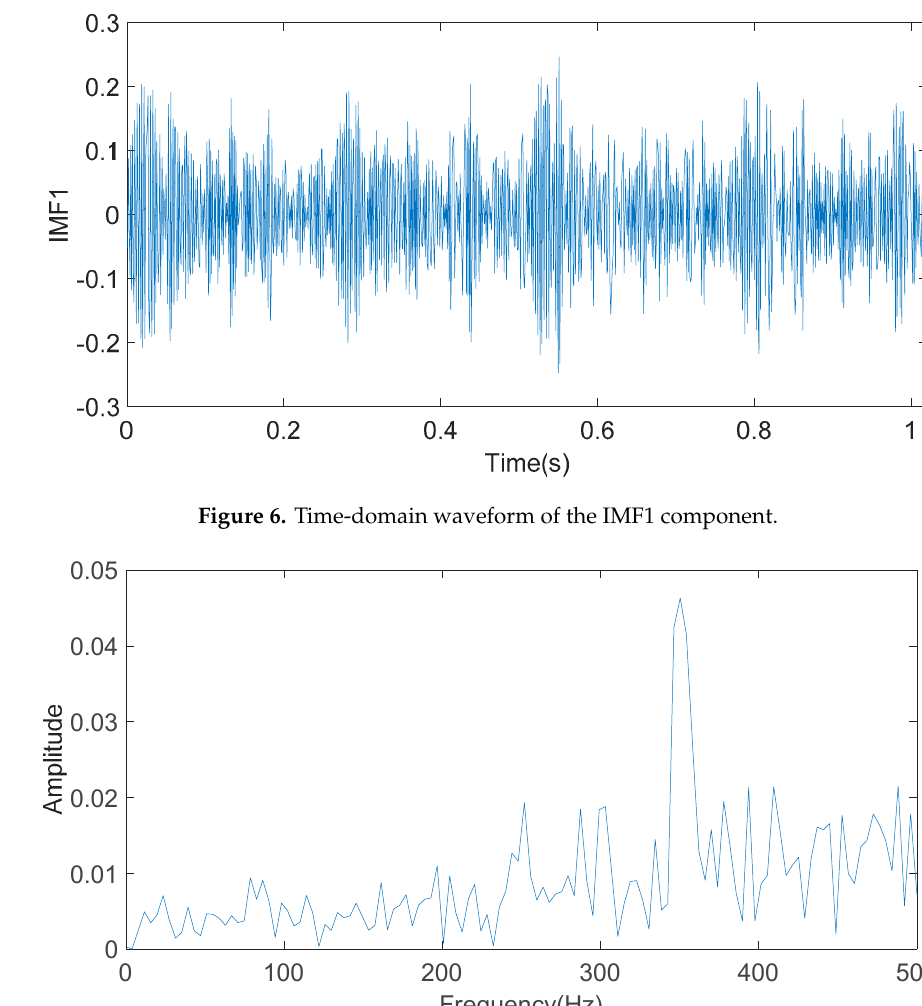
Figure 5. The energy weight value of eight Intrinsic modal Function (IMF) components.